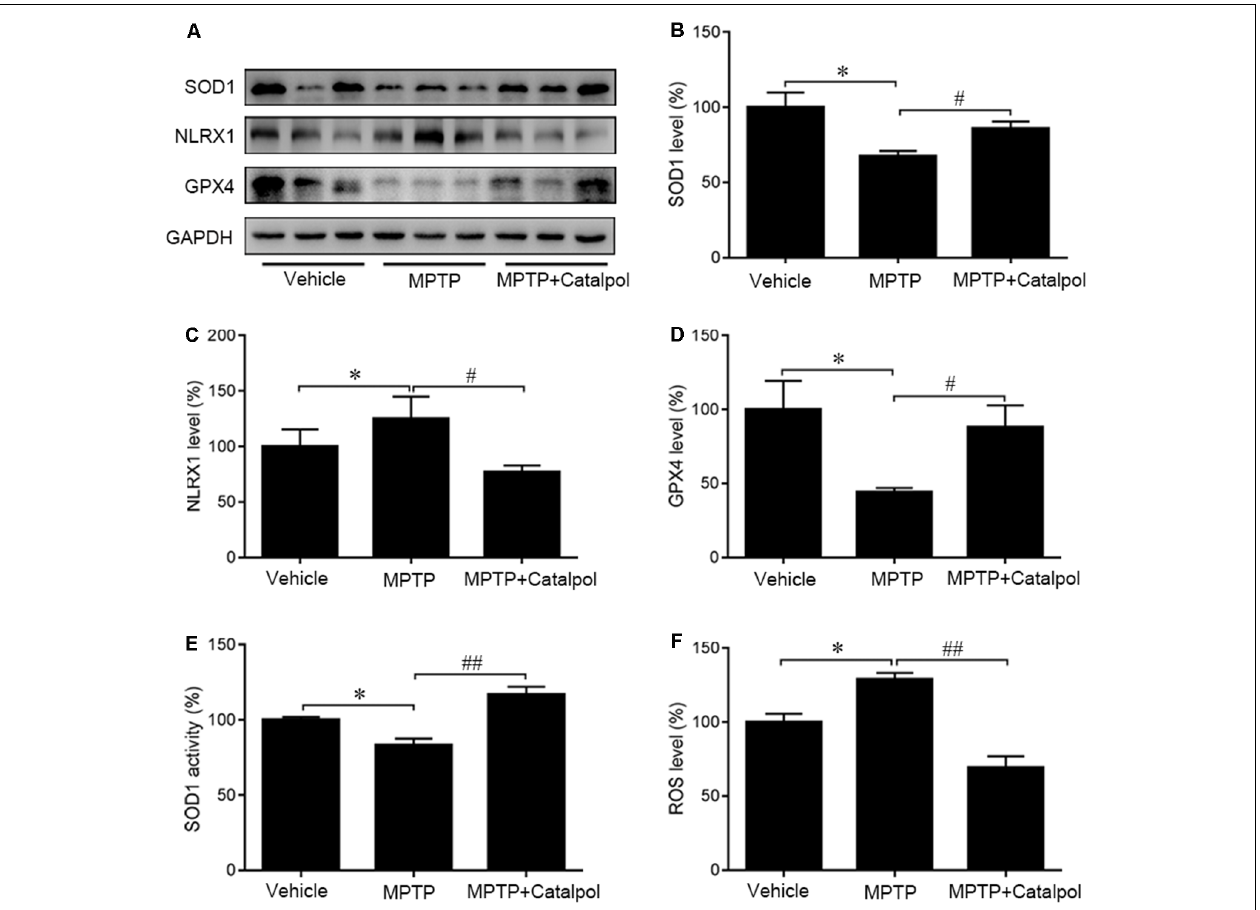
FIGURE 5 | Protective effects of catalpol against oxidative stress in the SN of MPTP-treated mice. (A) SOD1, NLRX1, and GPX4 protein expression as determined by western blotting. Glyceraldehyde 3-phosphate dehydrogenase (GAPDH) served as the loading control. (B–D) Quantitative analysis of SOD1, NLRX1, and GPX4 protein levels. (E) Changes in SOD1 activity in the SN of mice. (F) Reactive oxygen species (ROS) production in the SN detected with the dichlorofluorescein diacetate probe. Data represent mean ± SEM; n = 6–8 mice per group. The P -values were calculated using one-way ANOVA. ∗ P < 0.05 vs. vehicle group; # P < 0.05, ## P < 0.01 vs. MPTP-induced